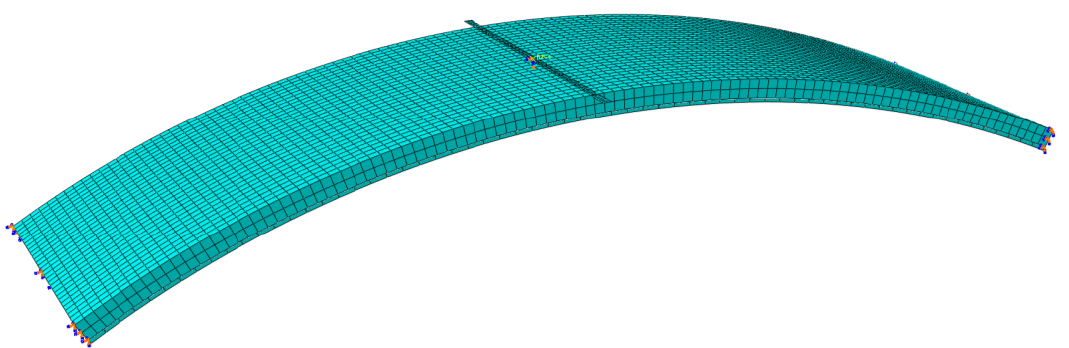
Figure 13. Boundary condition and loading for thin-shell structure.